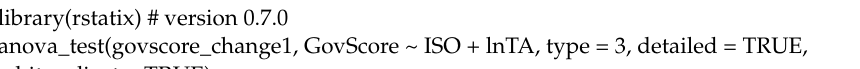
Algorithm A1: Code selection in RStudio for the ANCOVA and post-hoc analysis library(rstatix) # version